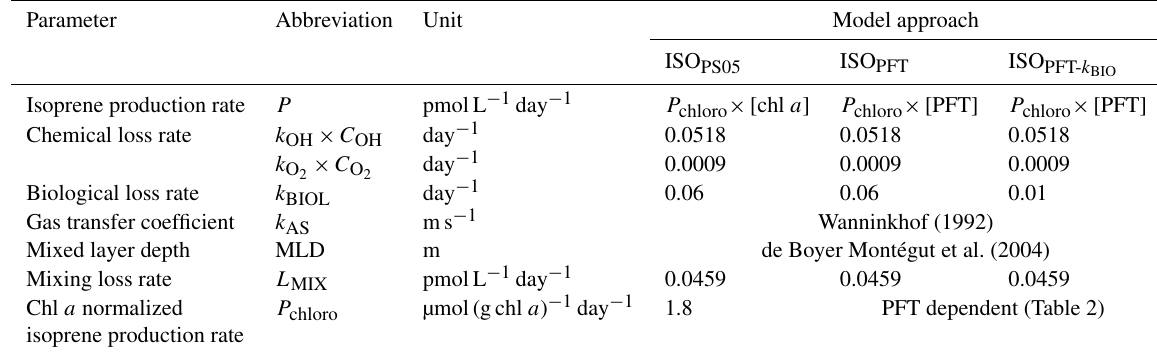
ISO PS05 ISO PFT